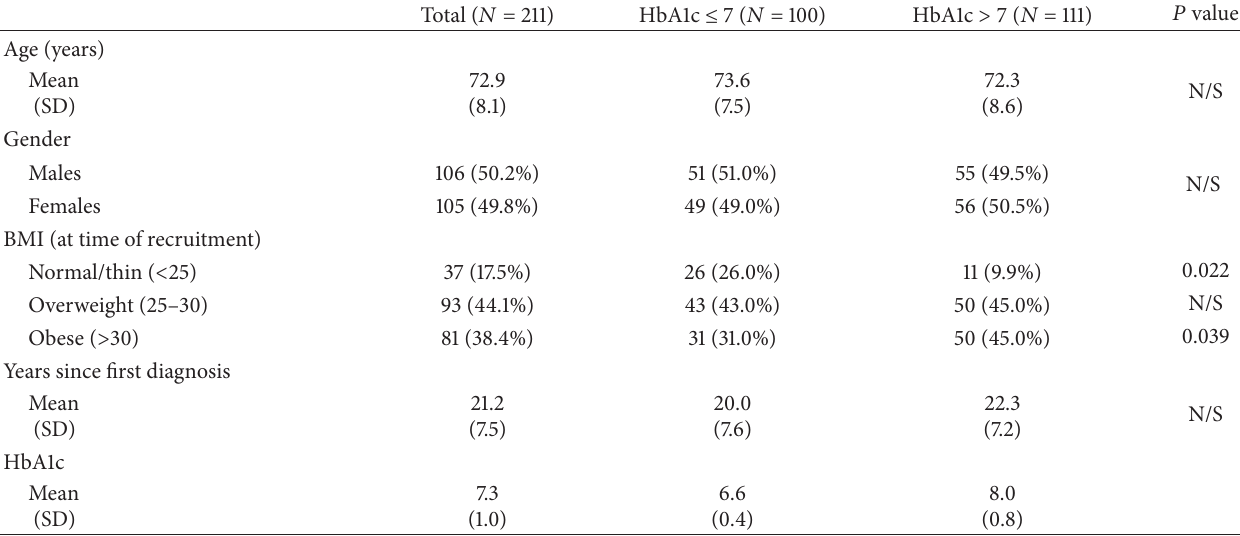
Table 1: Demographic characteristics.